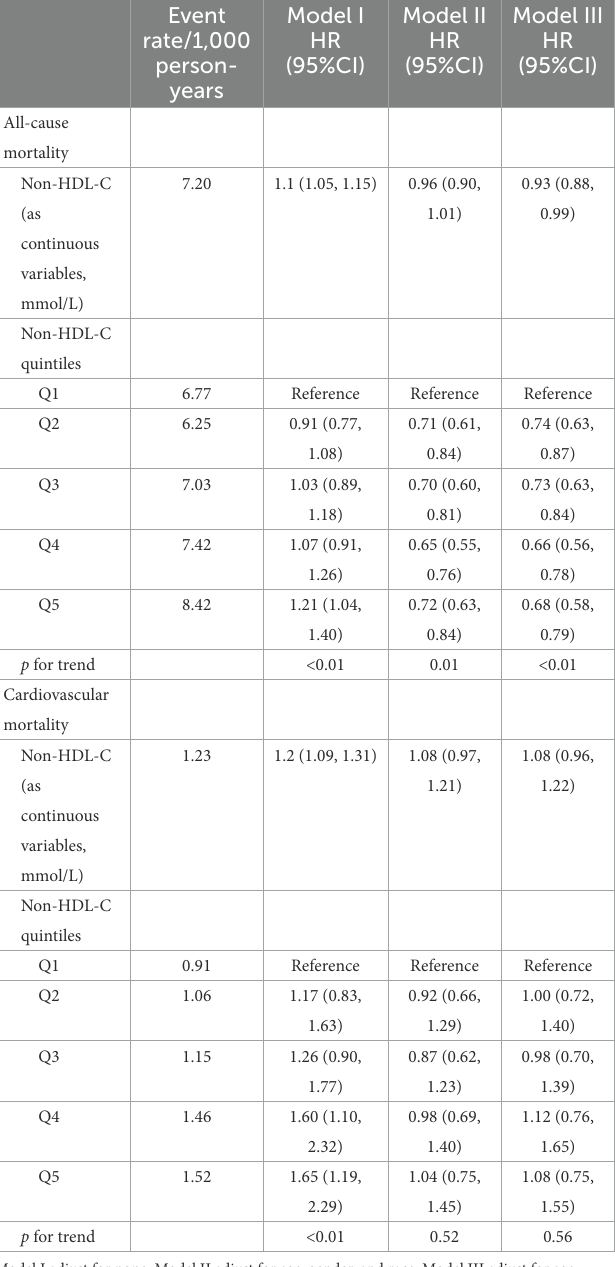
Model I adjust for none. Model II adjust for age, gender, and race. Model III adjust for age, gender, race, smoking, body mass index, systolic blood pressure, family income, education level, physical activity, estimated glomerular filtration rate, comorbidities (diabetes and hypertension), and medicine use (antihypertensive drugs, hypoglycemic agents, and lipid- lowering drugs). HR, hazard ratio; CI, confidence interval; Q,